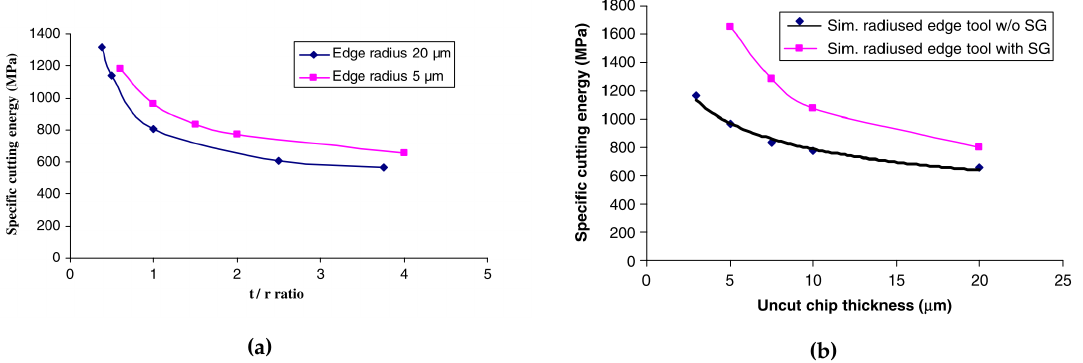
Figure 10. Predicted effect of the tool radius on the Specific Cutting Energy Variation during orthogonal cutting test ( a ), and effect of the adoption of a SGT on the predicted Specific Cutting Energy ( b )